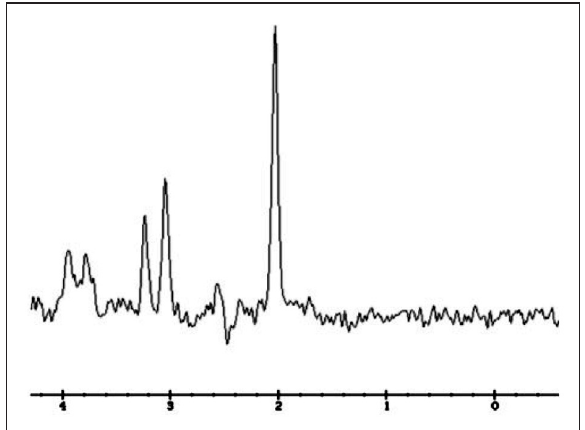
Figure 2. MR-spectroscopy. The main resonance peaks correspond to N- acetylaspartate (NAA, 2.0 ppm), glutamine glutamate (Glx, 2.1-2.5 ppm), creatine phosphocreatine (Cr, 3.02 ppm), choline-containing compounds (Cho, 3.2 ppm), and myo-inositol (Ins, 3.55 ppm). The initial spectrum showed no increase in the glutamate glutamine region and a decrease in the myo-inositol and choline